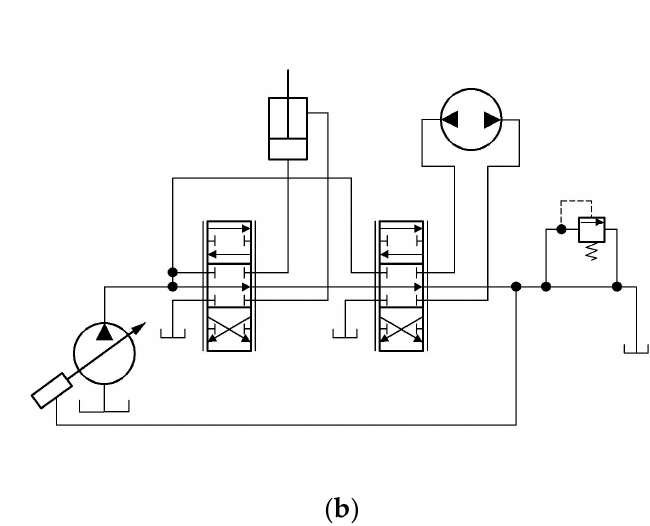
Figure 2. Negative flow-control system. ( a ) Structure diagram of negative flow-control system. ( b ) Schematic diagram of negative flow-control system.